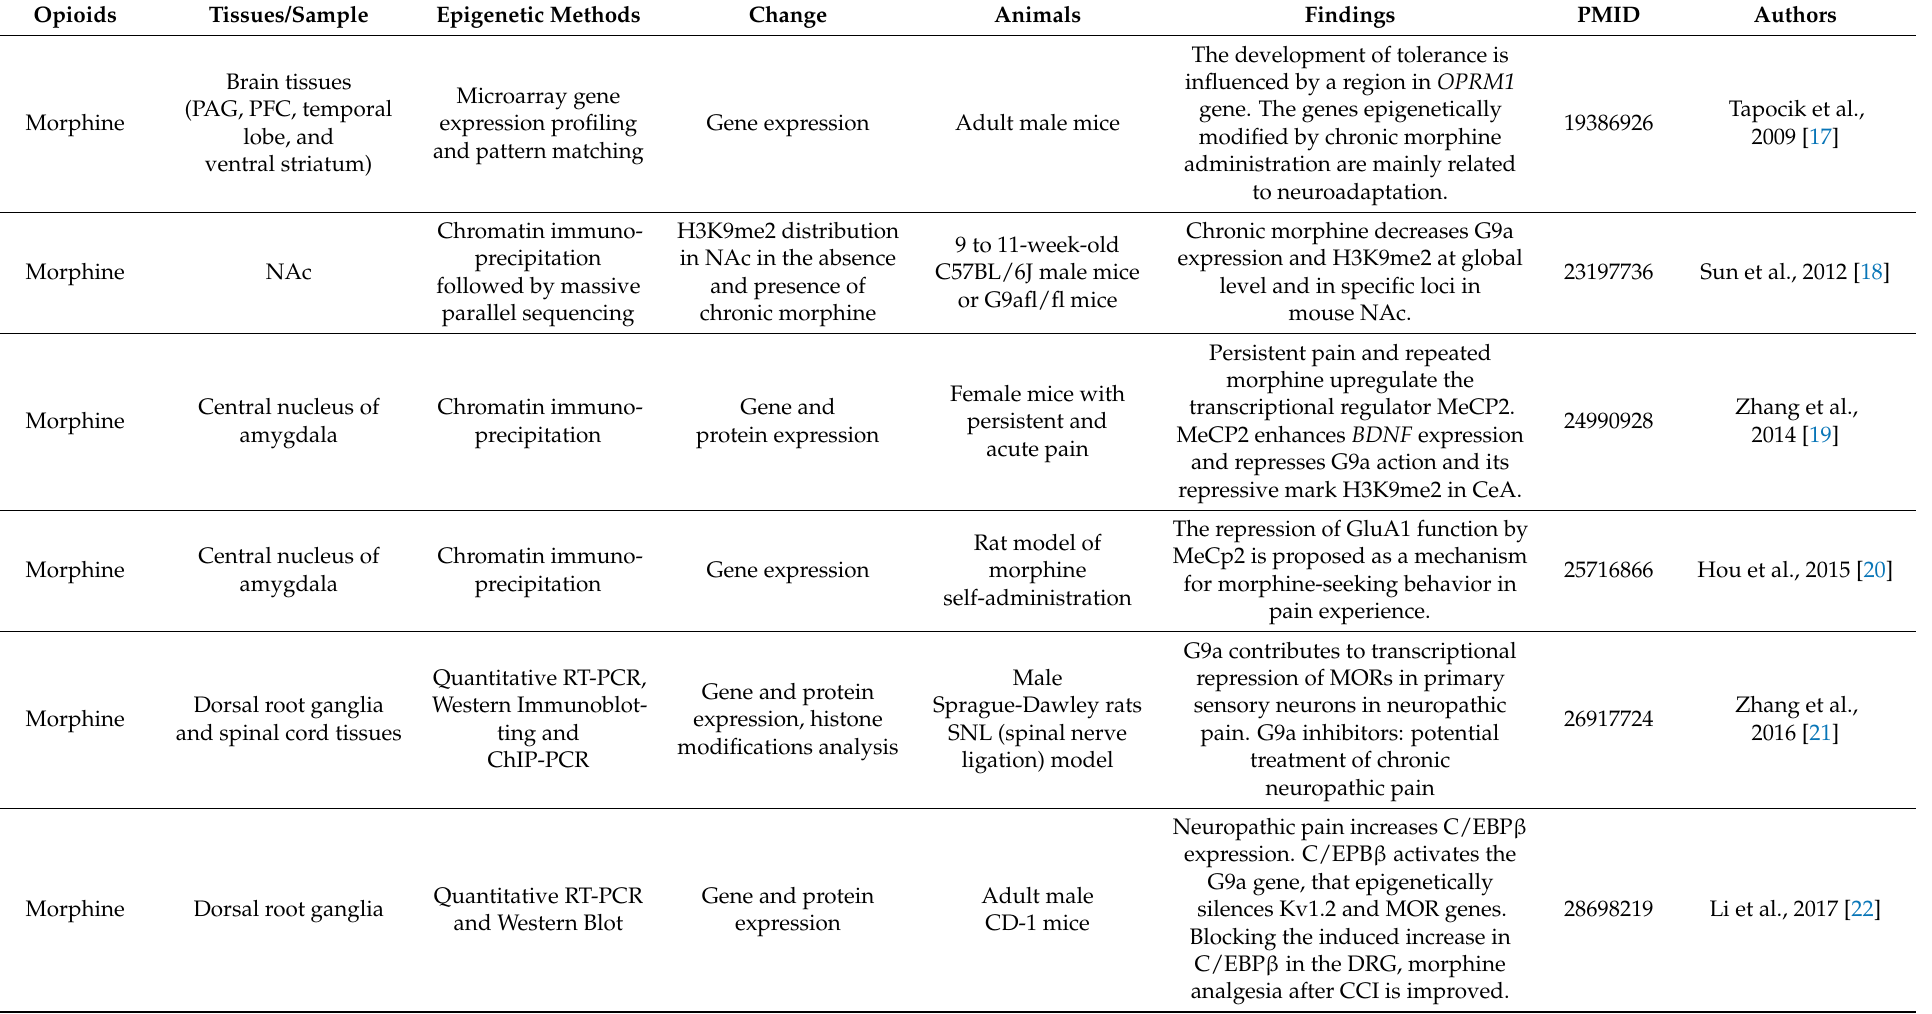
Table 1. Epigenetic changes after prescribed opioid exposure in experimental